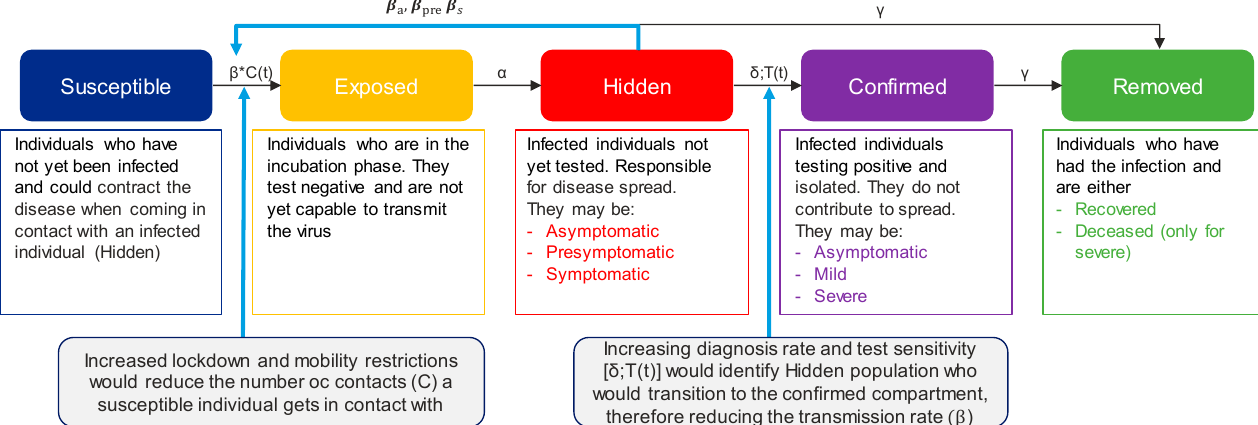
Figure 1. Diagram of the modified SEIR model. β represents the transmission rate and is adjusted based on whether the infectious individual is asymptomatic ( β a = 0.002), pre-symptomatic ( β s = 0.186) or symptomatic ( β pre = 0.01); C(t) is the number of contacts at that moment t; α is the incubation time ( α = 0.18); δ is the diagnosis rate and depends on the number of tests executed at that moment t [T(t)], the sensitivity of the test and the spread of the infection; γ is the recovery rate, which is adjusted based on whether the patient is mild ( γ = 0.07) or severe ( γ R = 0.02) and the death rate for severe patients ( γ D =0.009).